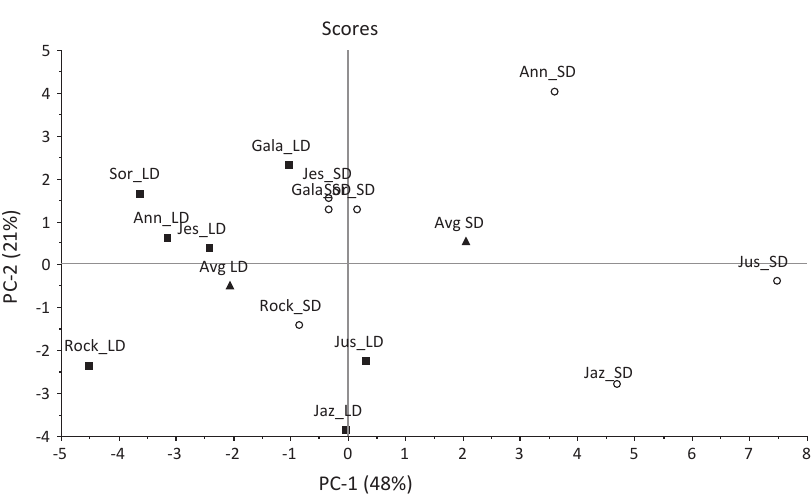
Fig. 1. PCA Scores plot. The SD (“8h”) photoperiod samples are marked by open circles and LD (“15h”) photoperiod samples are marked by squares. The averages of all SD (“Avg SD”) and LD (“Avg LD”) samples are marked by triangles in the